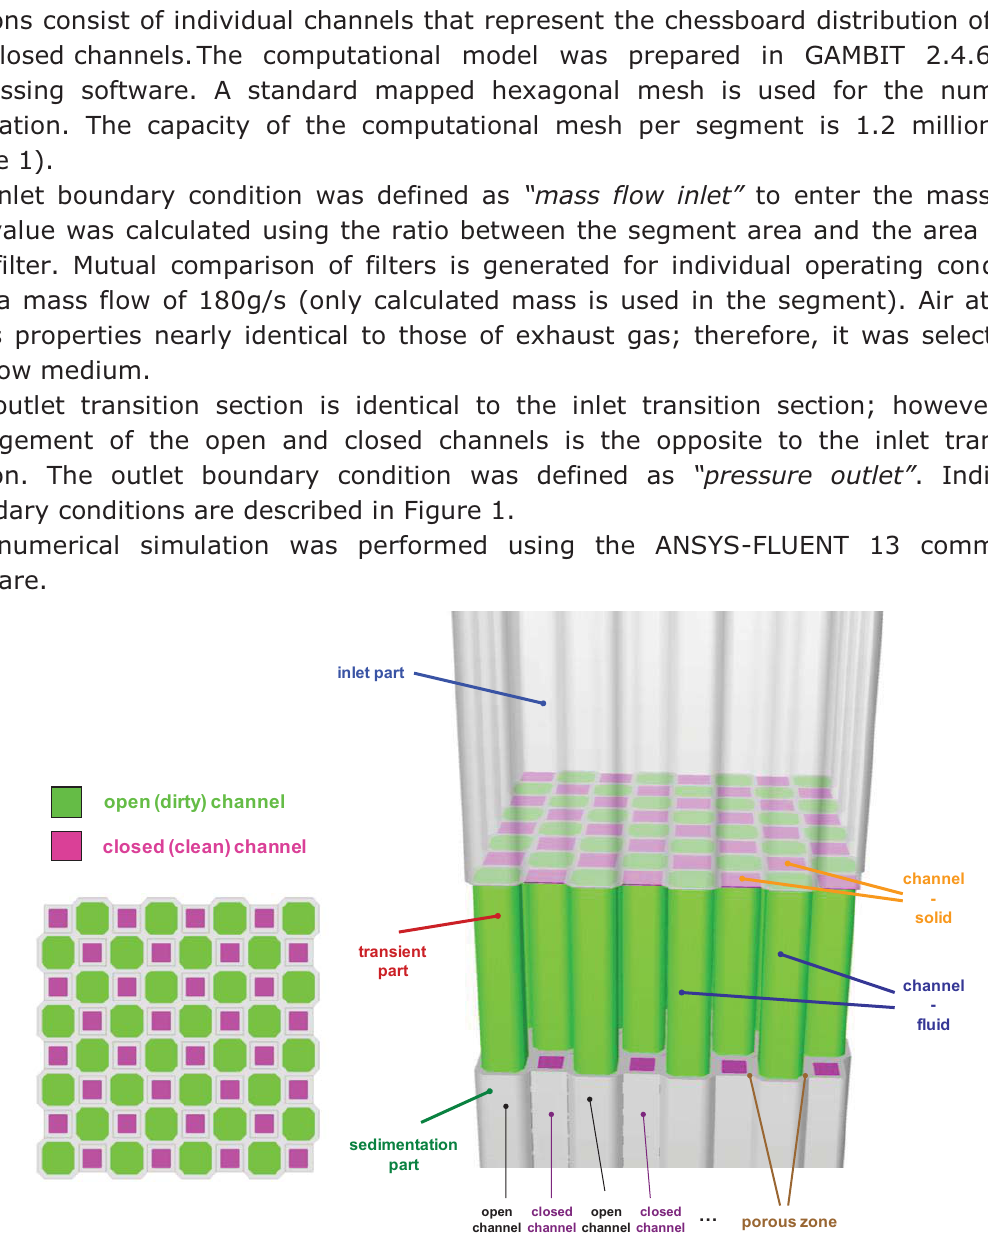
Figure 1: Computational model showing individual sections and boundary